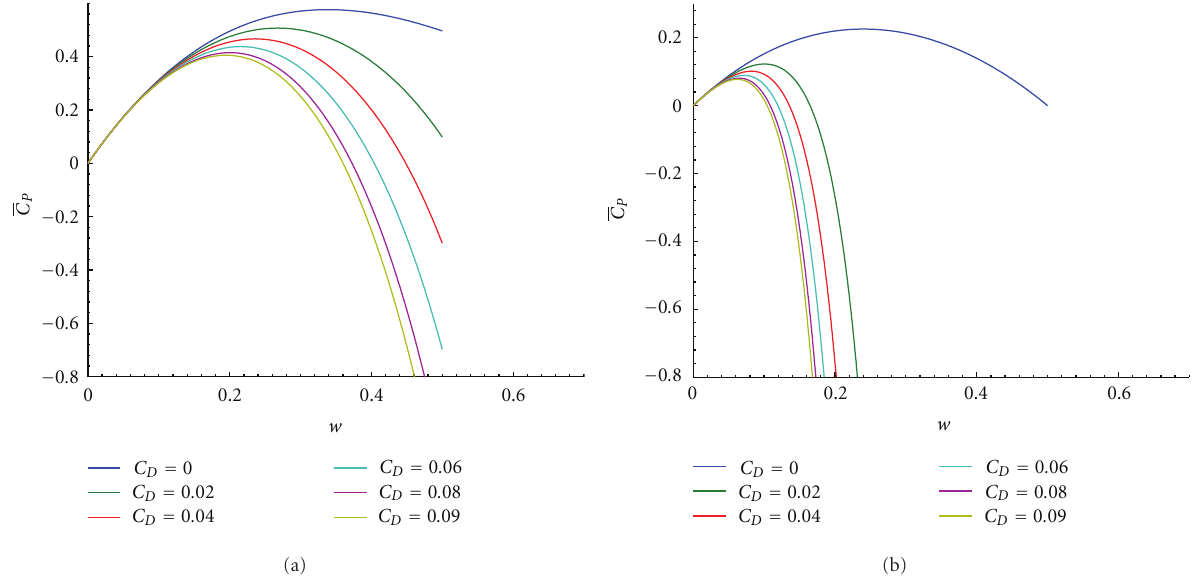
Figure 17: (a) C P versus w for θ = 0 ◦ and γ = 15 ◦ and (b) C P versus w for θ = 0 ◦ and γ = 60 ◦ .